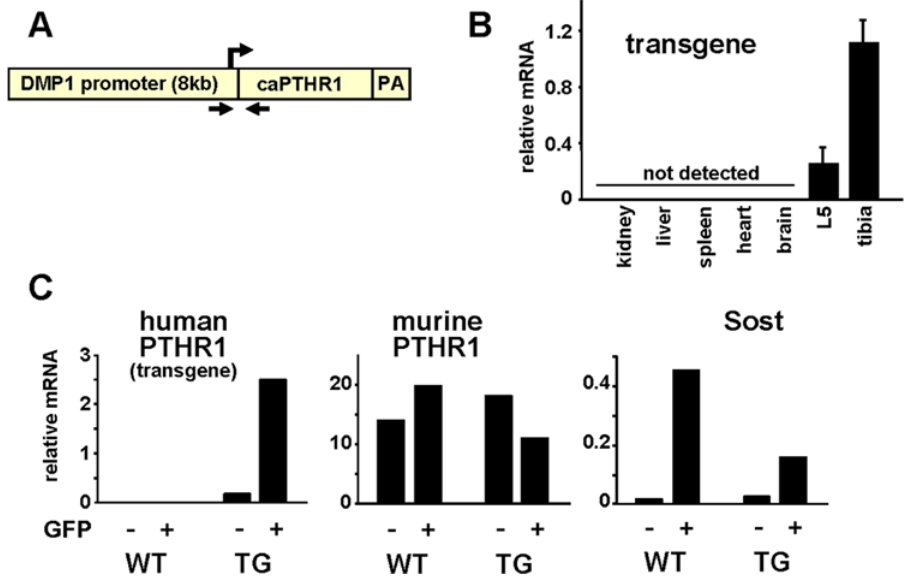
Figure 1. Generation of DMP1-caPTHR1 Transgenic Mice. (A) Schematic representation of the DMP1-caPTHR1 transgene. The transgene contains the cDNA encoding the H223R constitutively active mutant of PTHR1 (caPTHR1) inserted downstream from a 12-kb DNA fragment containing 8 kb of the murine DMP1 5 9 -flanking region, first exon, first intron, and 17 bp of exon 2; a synthetic polyadenylation site was inserted downstream from the caPTHR1 sequence. Arrows indicate the sites recognized by primers used for genotyping. (B) Quantitative RT-PCR analysis of DMP1-caPTHR1 mRNA from the 5 th lumbar vertebrae (L5), tibia, and soft tissues of 10.5-week-old mice, normalized to the housekeeping gene ribosomal protein S2. Bars represent the mean 6 SD of 4 mice. (C) Expression of the human PTHR1, murine PTHR1, and Sost determined by quantitative RT-PCR in freshly isolated osteoblast-enriched (GFP 2 ) and osteocyte-enriched (GFP + ) cell preparations obtained from neonatal mice without (WT) or with (TG) the DMP1-caPTHR1 transgene.